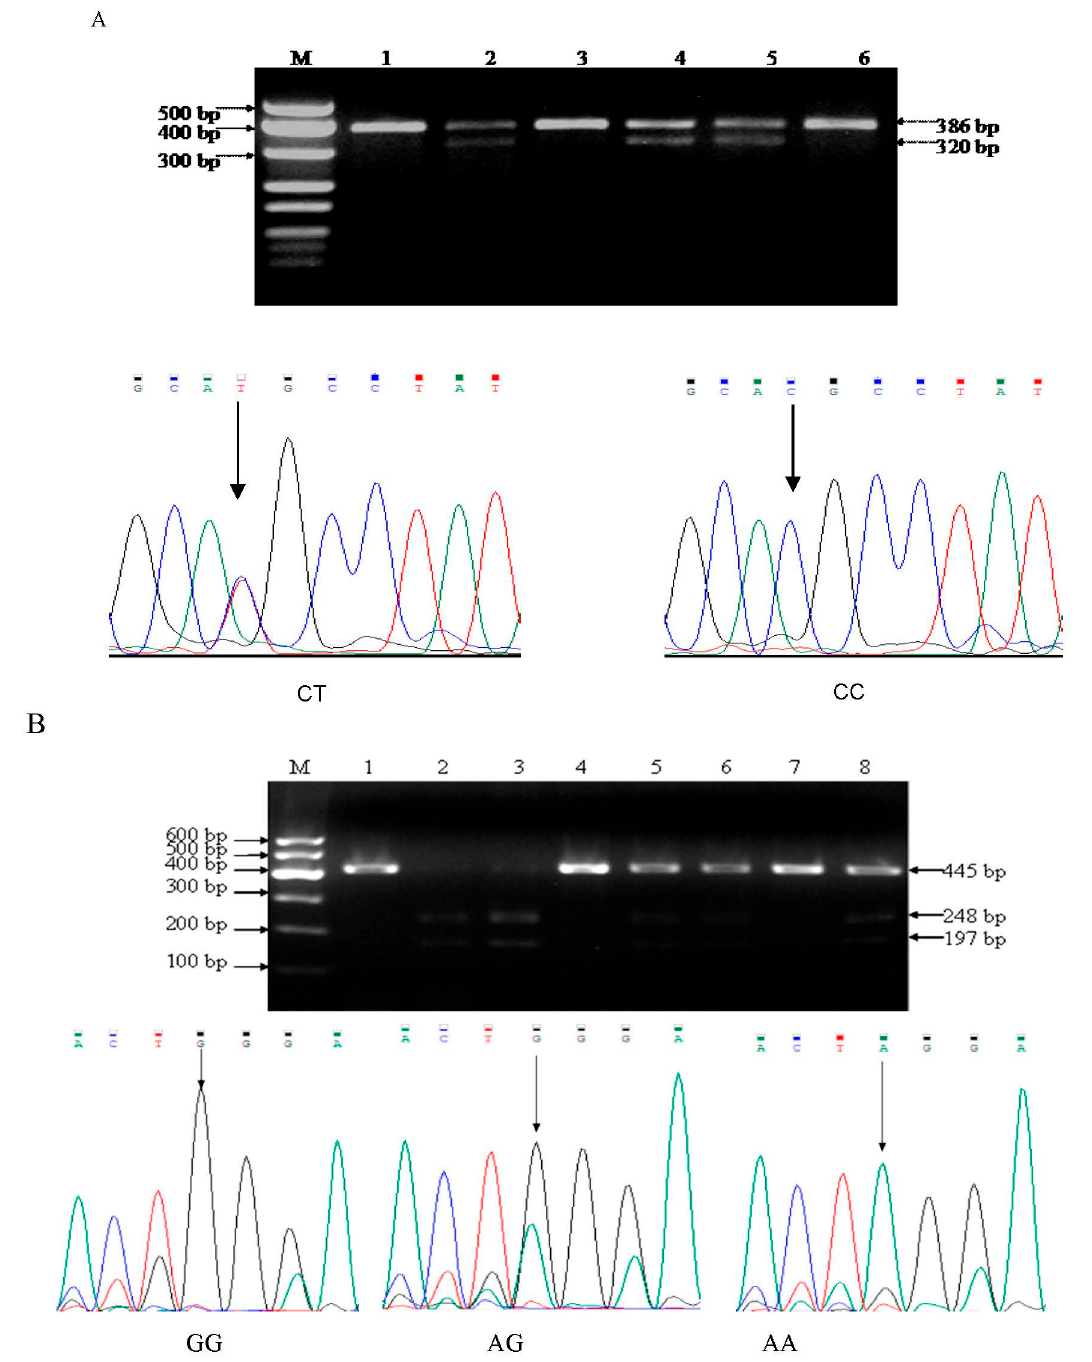
Figure 1. The polymerase chain reaction-restriction fragment length polymorphism (PCR-RFLP) analyses and direct-sequence result of MMP9 and MMP13 genes polymorphism. ( A ) MMP9 polymorphisms. Lanes 1, 3, and 6 CC homozygous genotype (386 bp) and lanes 2, 4, and 5, CT heterozygous genotypes (386, 320, and 66 bp). ( B ) MMP13 polymorphisms. Lanes 2 and 3, AA homozygous genotypes (248 and 197 bp); lanes 1, 4, and 7, GG homozygous genotypes (445 bp); and lanes 5, 6, and 8, AG heterozygous genotypes (445, 248, and 197 bp).